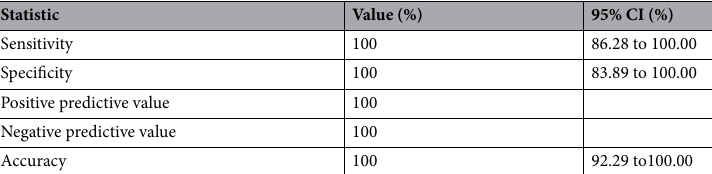
Table 4. Diagnoses: MI Imaging Assay versus Autopsy Gold Standard AD (Positive: N = 25) versus Non-ADD (Negative; N = 21). https:// www. medca lc. org/ calc/ diagn ostic_ test.